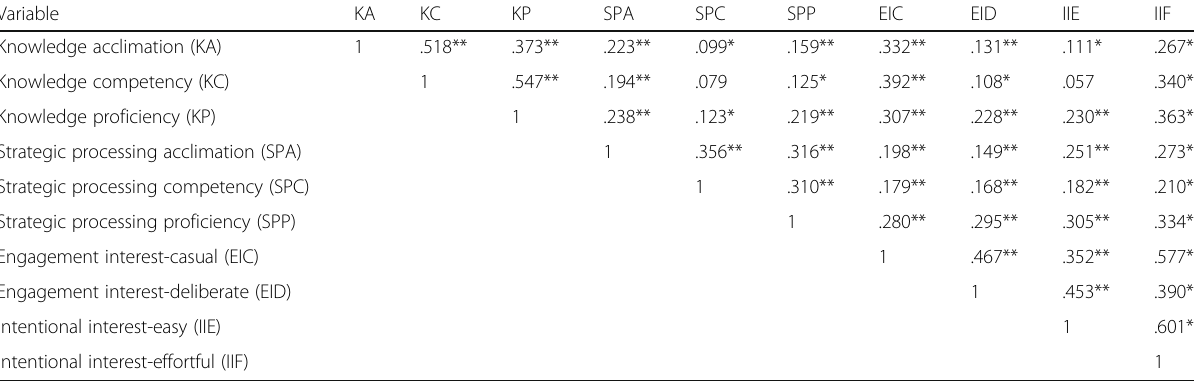
Table 11 Non-parametric Spearman correlations among the variables Variable